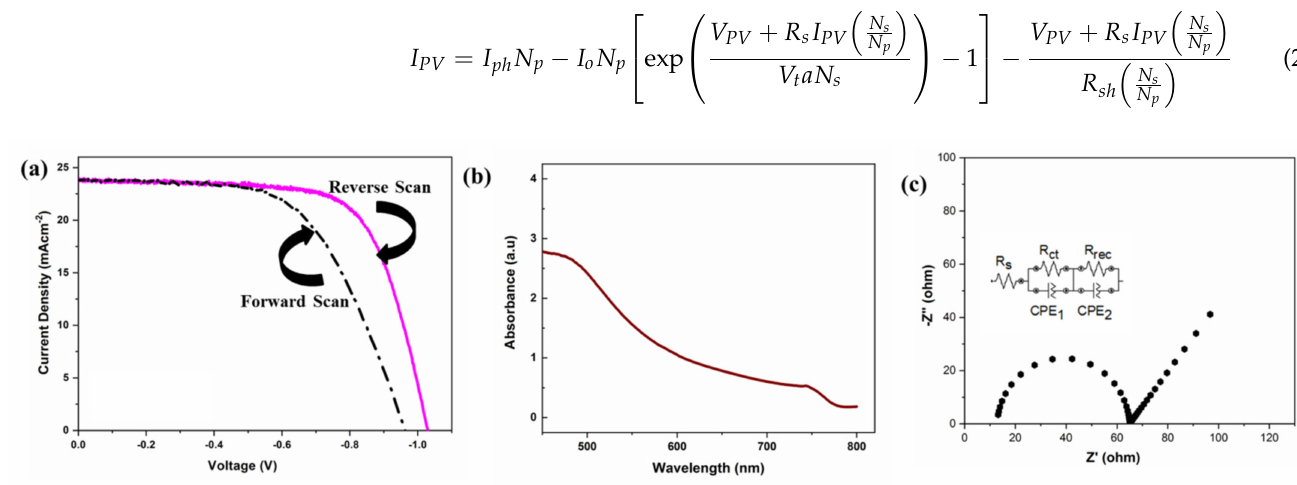
Figure 3. ( a ) The device J-V curves (reverse and forward scans). ( b ) Perovskite deposited upon TiO 2 layer absorbance spectra. ( c ) The complete device impedance.